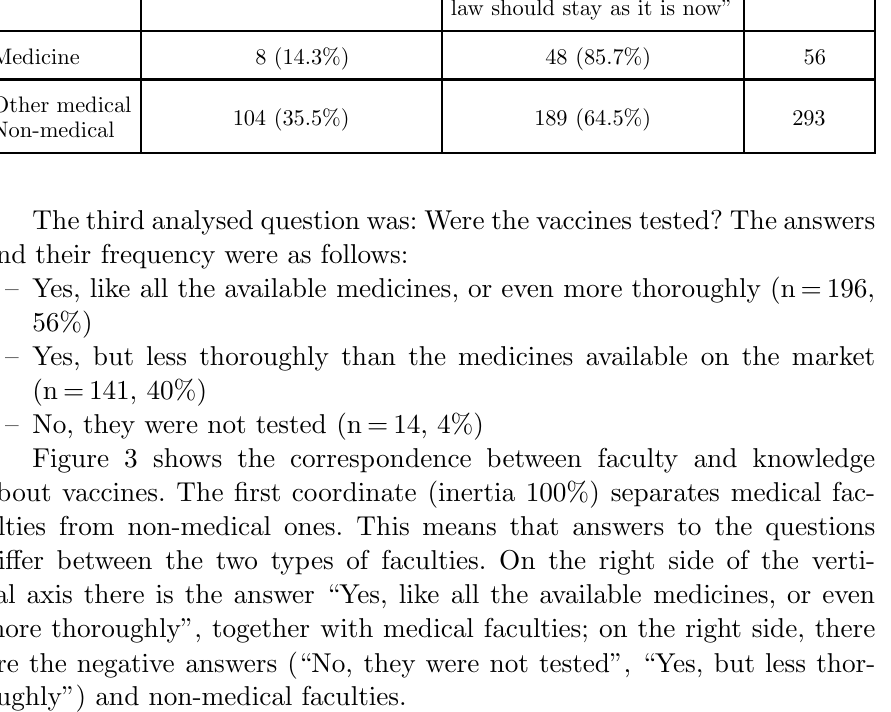
Table 2. Correspondence between faculty and opinion concerning mask-wear- ing “Yes, but I think that “Yes and I think that the law should be less the law should be more restrictive” restrictive” “No” “Yes and I think that the law should stay as it is now” Medicine 8 (14.3%) 48 (85.7%) 56 Other medical 104 (35.5%) 189 (64.5%) 293